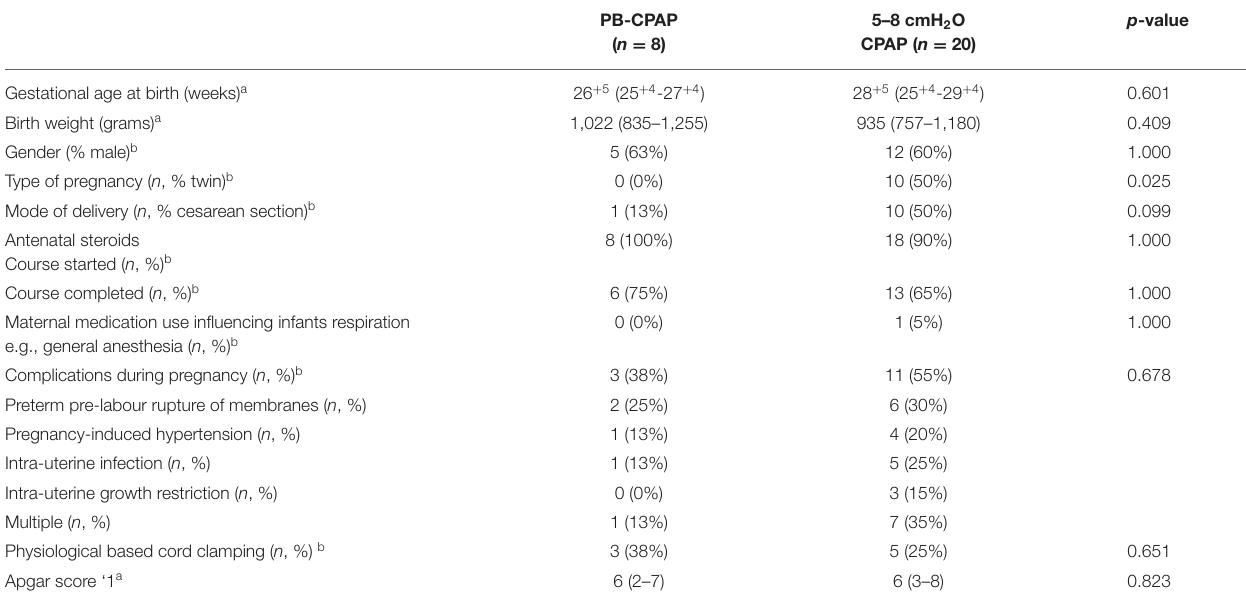
TABLE 1 | Demographical data (per-protocol).